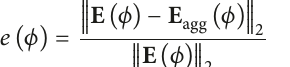
numbers of CSBs for levels 2, 3, and 4 are 5738, 1758, and 682, as listed in Table 1. Considering both 𝜃 and 𝜙 components of CSBs, the dimensions of the aggregation matrices for level 2 and level 3 are 11476 × 3516 and 3516 × 1364 ,